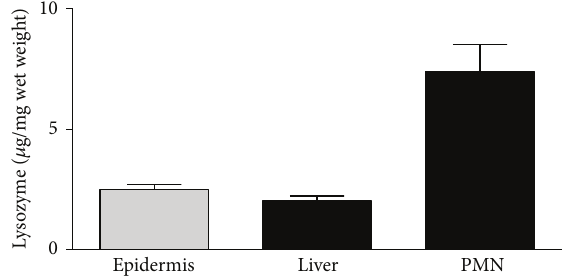
Figure 4: Source of lysozyme in different tissues . Lysozyme levels in tissue of healthy donors were analyzed by ELISA. Highest lysozyme concentration was detected in neutrophils, whereas liver and epidermis showed nearly similar